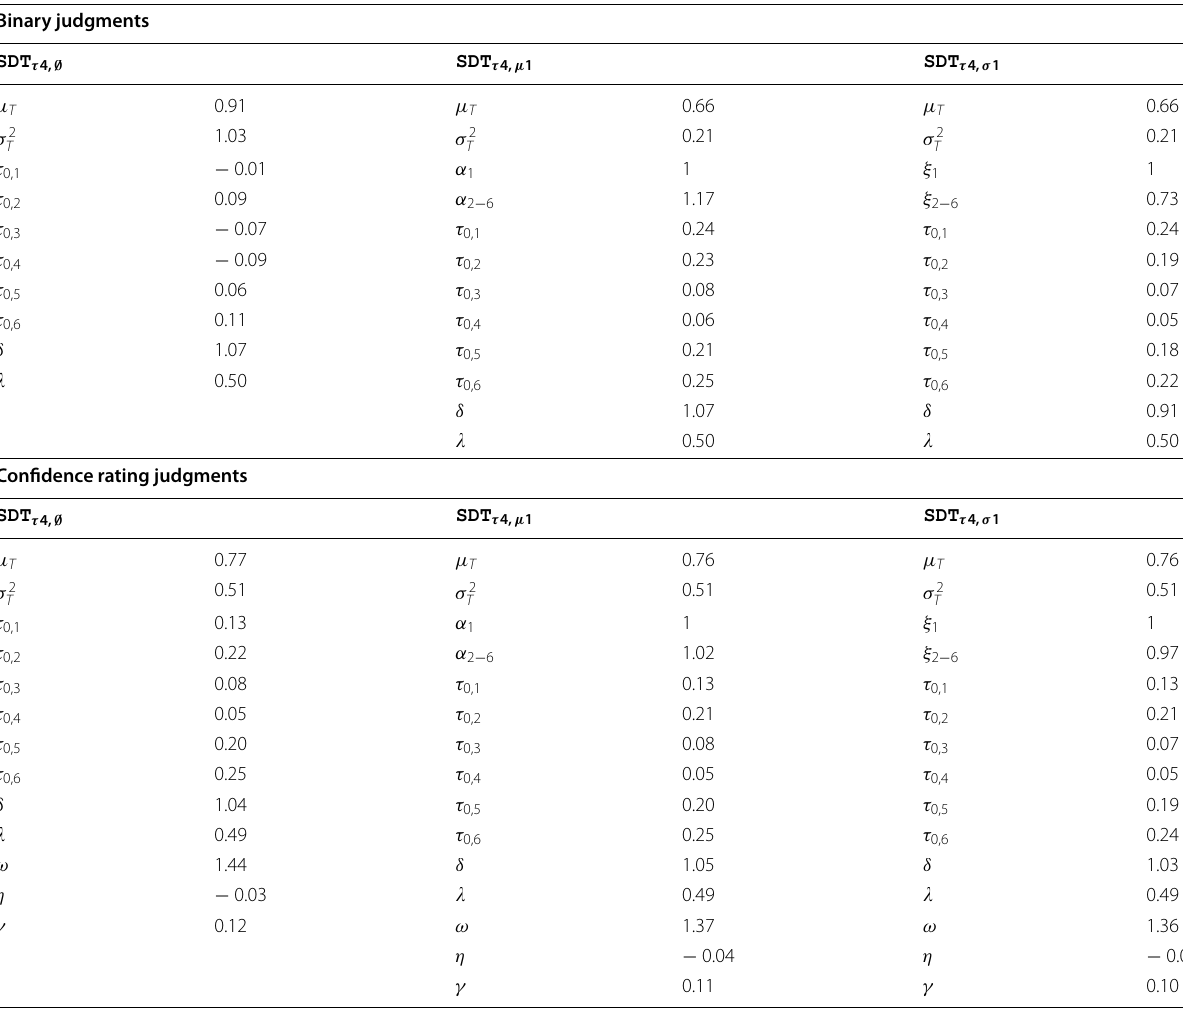
Table 3 Parameter estimates for models SDT τ 4, ∅ , SDT τ 4, µ 1 , and SDT τ 4, σ 1 (reanalysis of Wilson et al.,